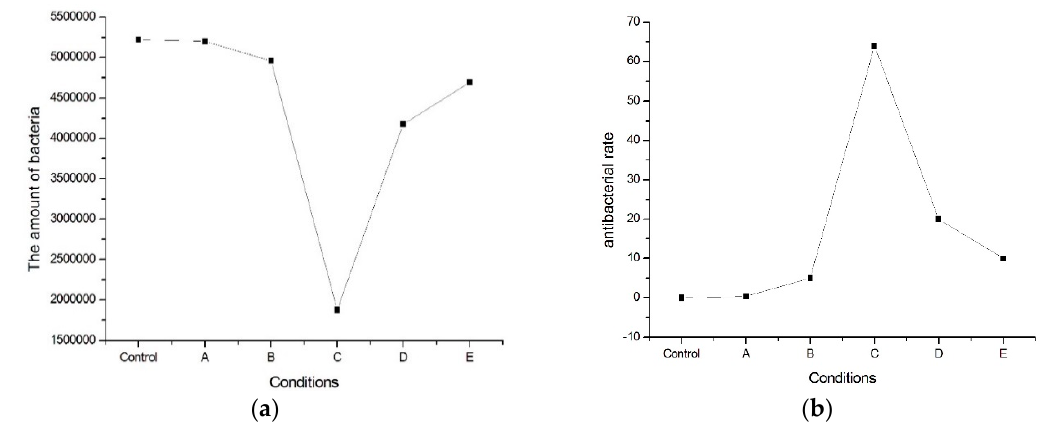
Figure 1. ( a ) The amount of E. coli bacteria and ( b ) E. coli bacterial rate of the present alloy with various heated treatments.